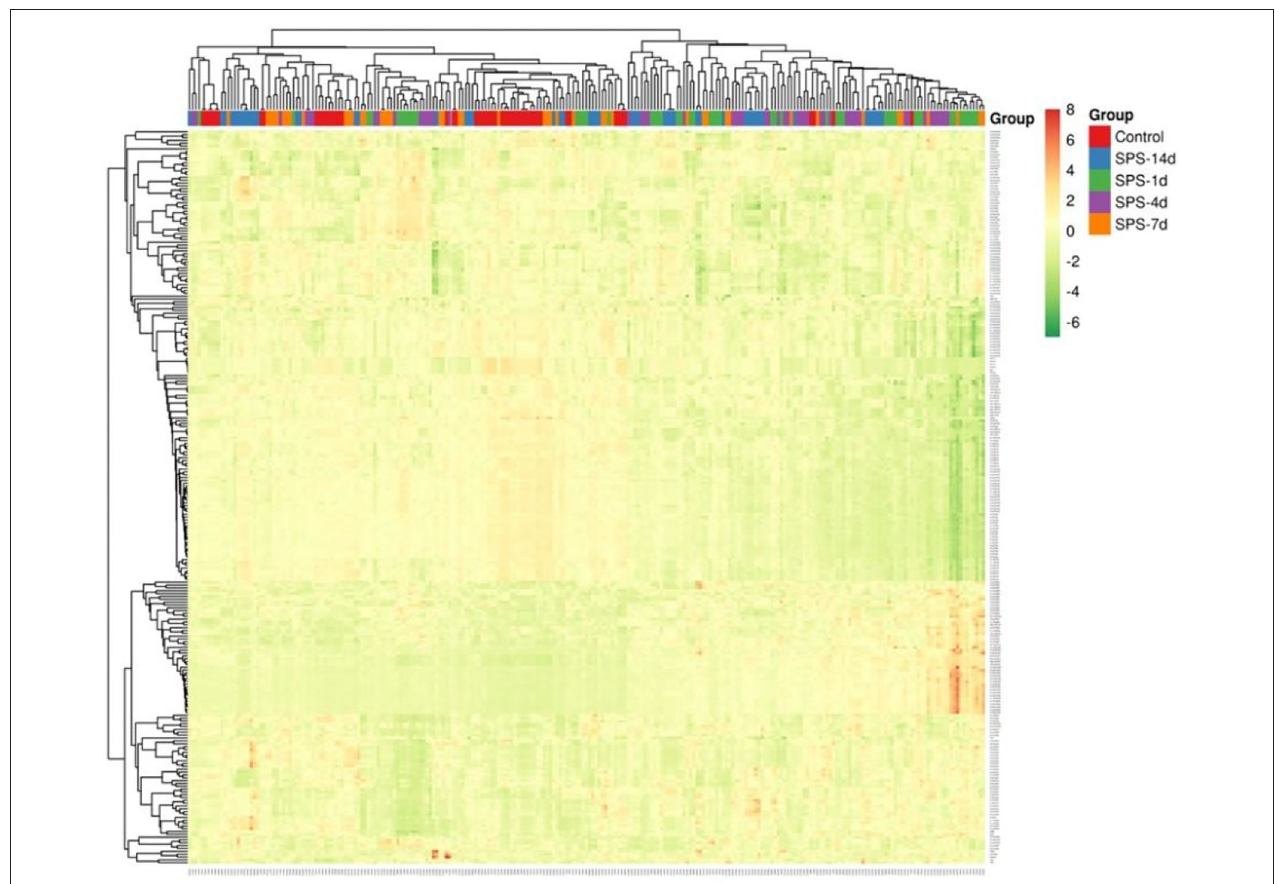
FIGURE 3 | Visualization of radiomics based on T2W images in mPFC. Cluster map of T2W-image radiomics in mPFC, with 245 ROIs (samples) from control and SPS groups on the x axis and 262 radiomic features on the y axis. Each feature was normalized to zero mean and unit standard variance. The ROIs of a given cluster (adjacent columns) shared similar radiomic features in correlation